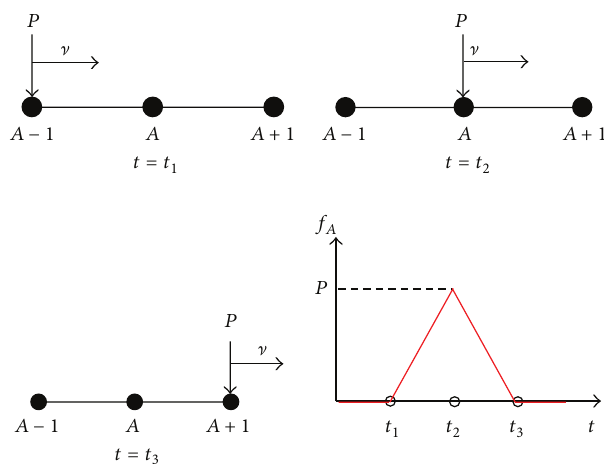
Figure9:Definitionofloadatnode 𝐴 formovingload 𝑃 inthefinite element